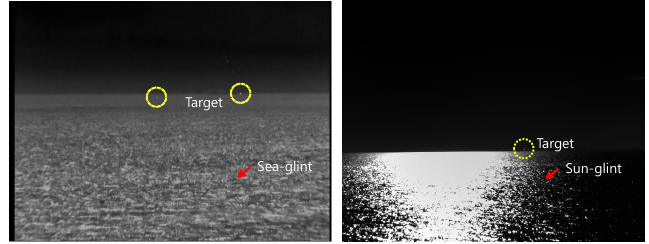
Figure 15. Example of sun-glint in the infrared search and track system.